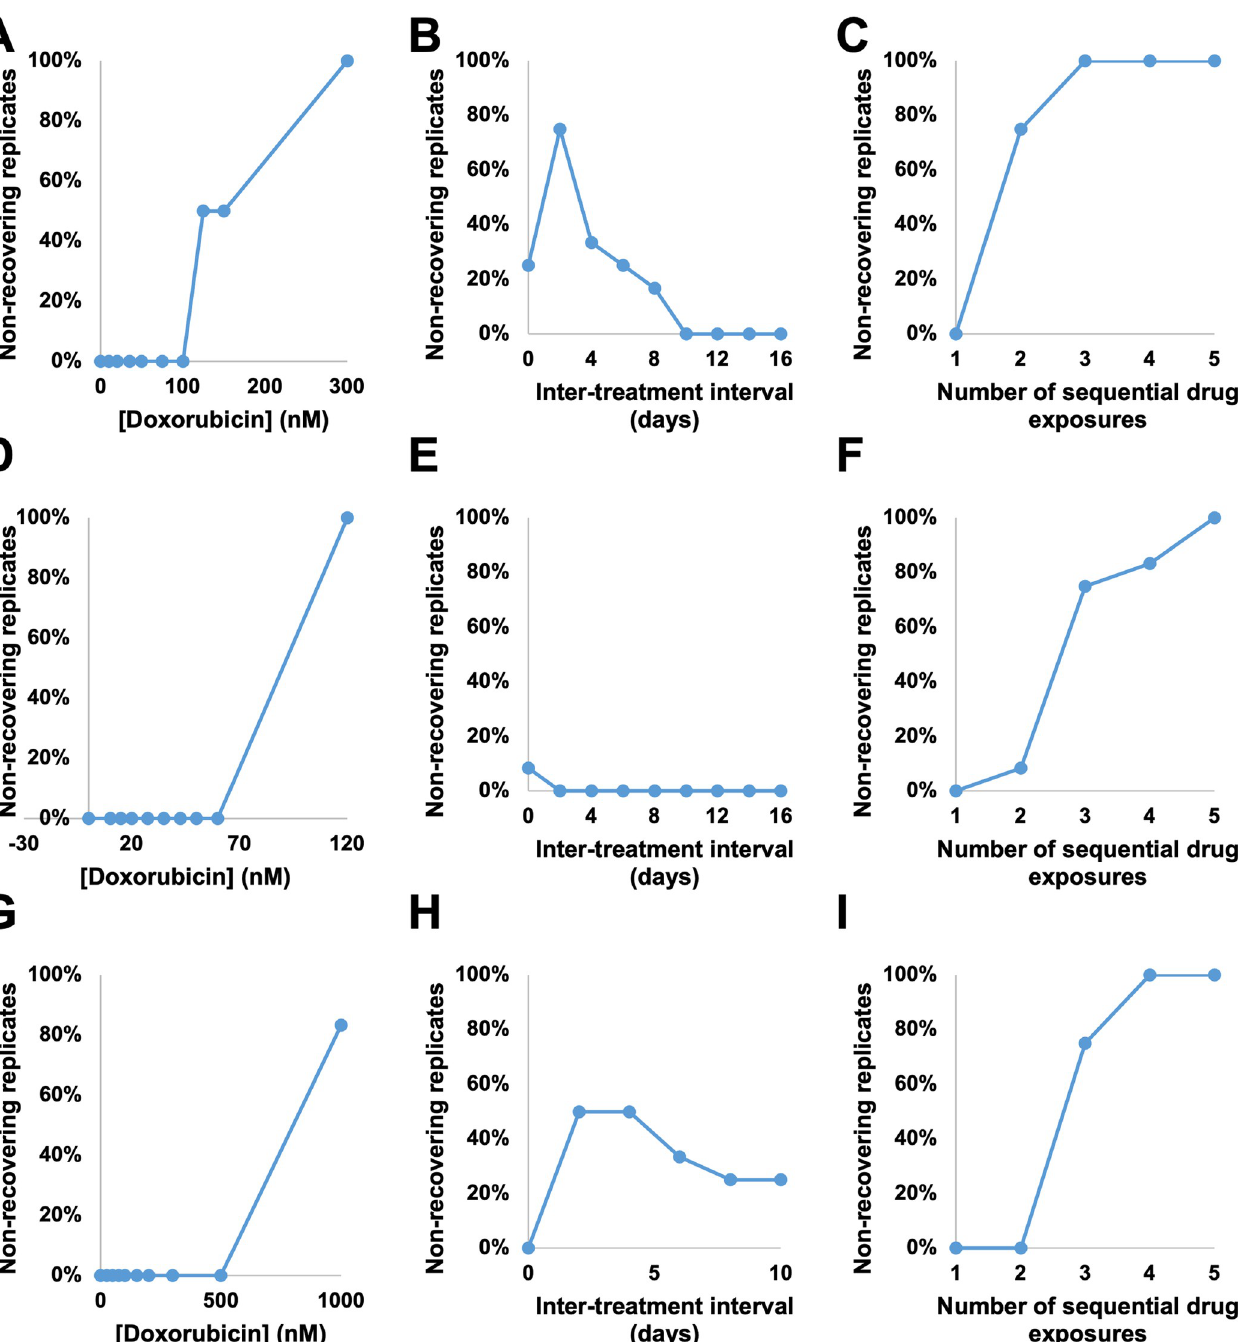
Fig 4. Percentage of non-recovering replicate cell populations. The percentage of replicate cultures which did not recover during the course of the experiment is shown as doxorubicin concentration varies in the MCF7 cell line (A), the BT474 cell line (D), and the MDA-MB-231 cell line (G), as the interval between two 24 hour doxorubicin exposures varies at 75 nM in the MCF7 cell line (B), at 35 nM in the BT474 cell line (E), and at 200 nM in the MDA-MB-231 cell line (H), and as the number of sequential 24 hour doxorubicin exposures varies at a two day interval and 75 nM in the MCF7 cell line (C), at a zero day interval (continuous exposure) and 35 nM in the BT474 cell line (F), and at a two day interval and 200 nM in the MDA-MB-231 cell line (I). Each value is the percentage of 6 (A, D, G) or 12 (B, C, E, F, H, I) replicates.